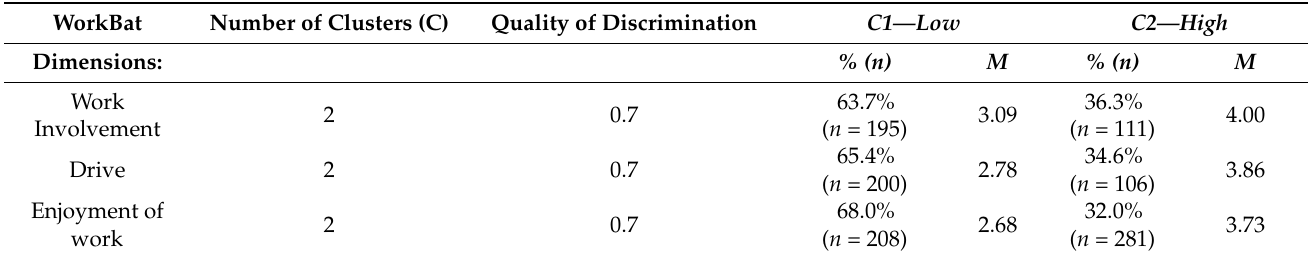
Table 4. Number of clusters, quality of discrimination, number of participants in each cluster ( n , %) and means (M) for the dimensions of the Workaholism